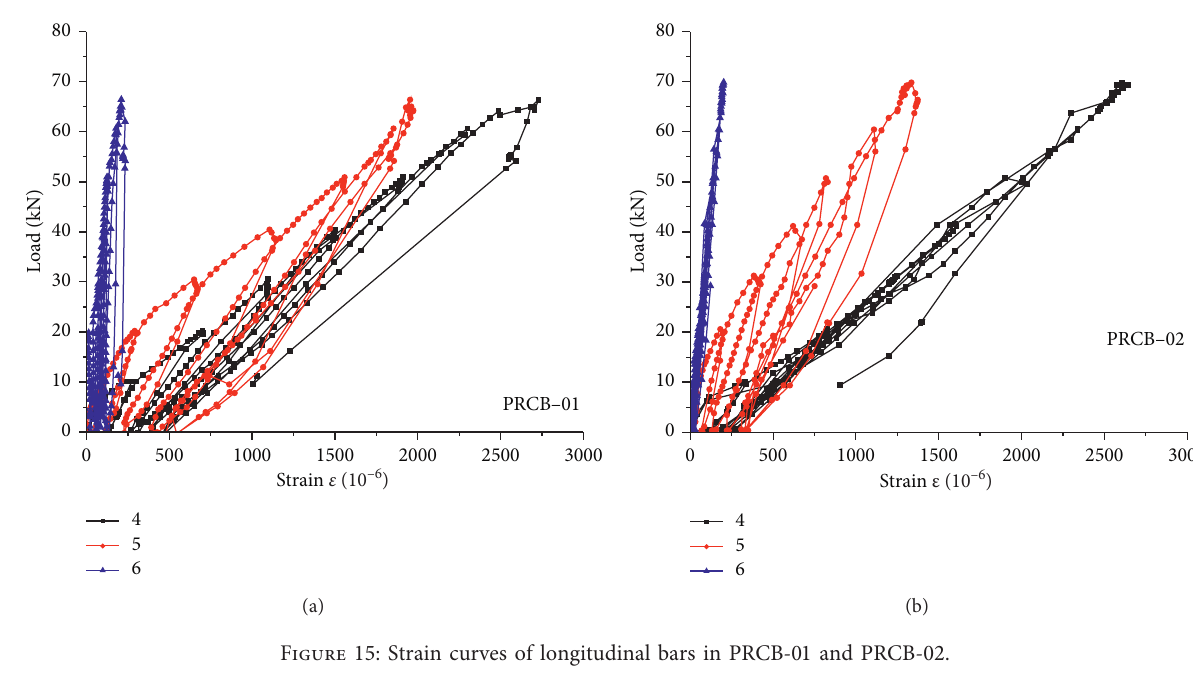
Figure 15: Strain curves of longitudinal bars in PRCB-01 and PRCB-02.